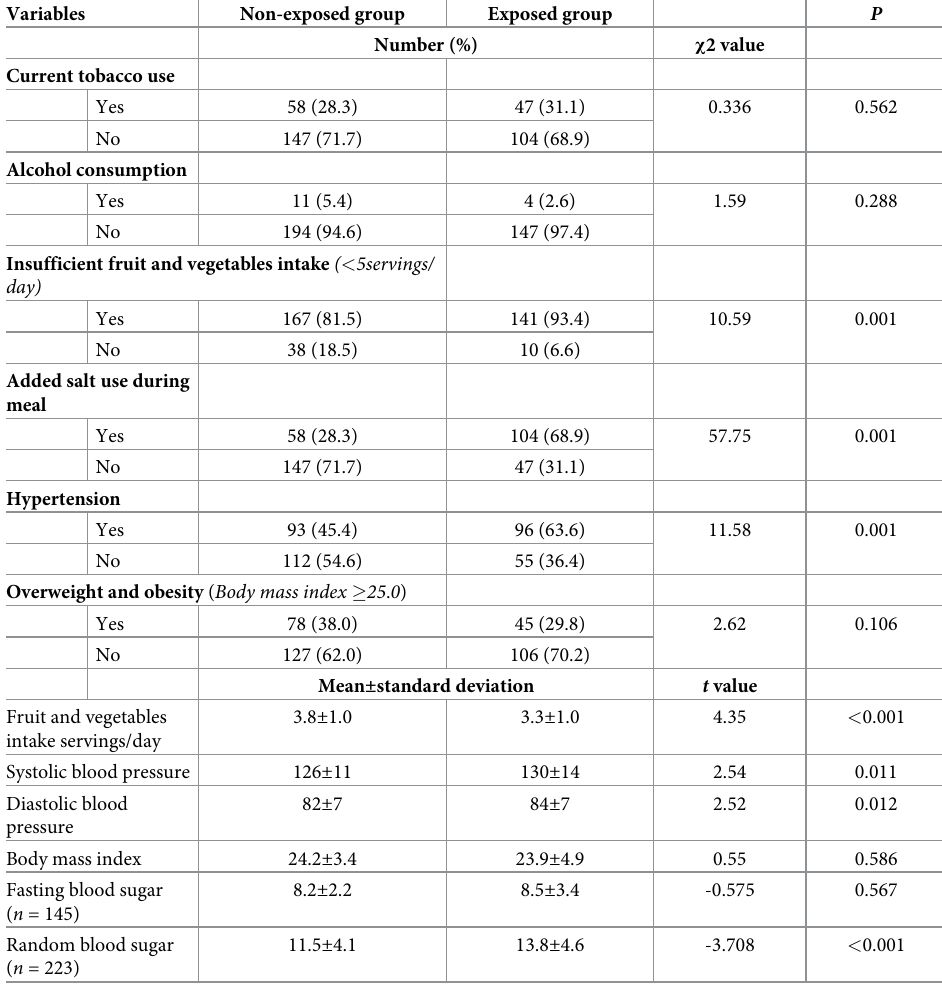
Table 2. Behavioral and metabolic risk factors of the high groundwater salinity non-exposed ( n = 205) and exposed ( n = 151) diabetic populations in Bangladesh (total n = 356).